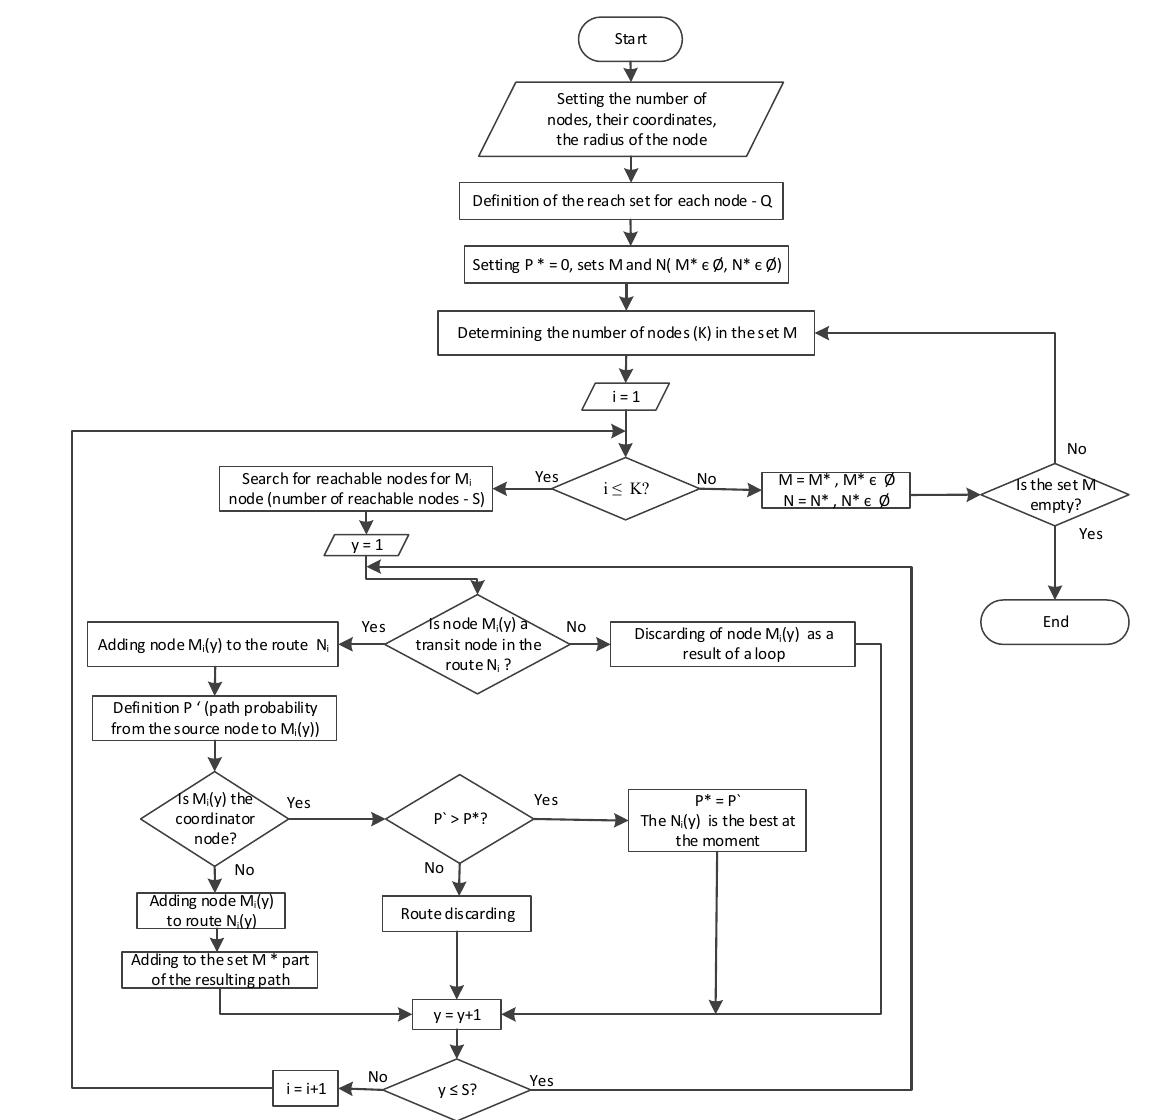
Figure 2. Block diagram of the developed ant Algorithm Algorithm 1. Ant algorithm (Figure 2)